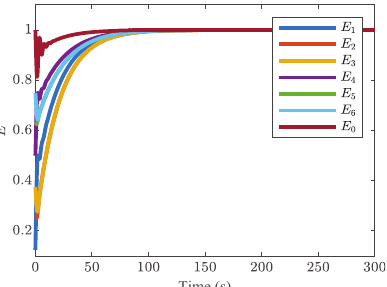
Figure 10. Influence of input time delay τ on SoC evolution and imbalance index δ in Case 6.